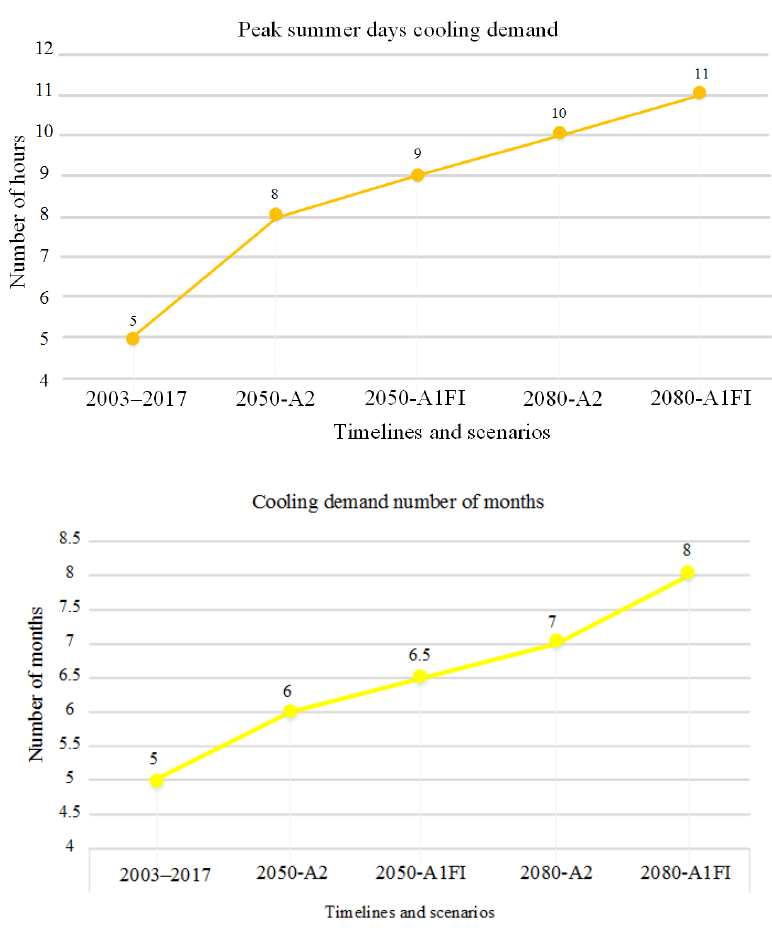
Fig. 8. Cooling Period Specific